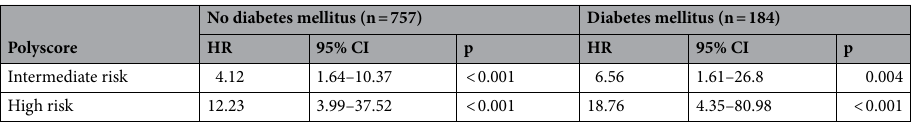
Table 2. Hazard ratios with simultaneous 95% confidence intervals for prediction of mortality in diabetics and non-diabetics. Reference: Polyscore low risk. HR hazard ratio, 95% CI simultaneous 95% confidence interval.